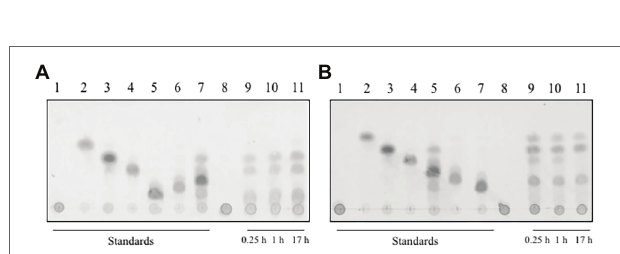
FIGURE 4 | Thin layer chromatography of the reaction products of (A) xylanase I and (B) xylanase II on a silica gel plate, with a running time of 40 min in organic solvent. The plate was incubated with 0.2% (w/v) oricin at 80 ° C for 40 min. The produced sugars are visualized as dark spots. (A) Lane 1: xylan, lane 2: xylose, lane 3: xylobiose, lane 4: xylotriose, lane 5: xylohexose, lane 6: xylopentose, lane 7: xylotetraose, lane 8: xylanase I + xylan after 0 h incubation, lane 9: xylanase I + xylan after 0.25 h incubation, lane 10: xylanase I + xylan after 1 h incubation, and lane 11; xylanase I + xylan after 17 h incubation. (B) Lane 1: